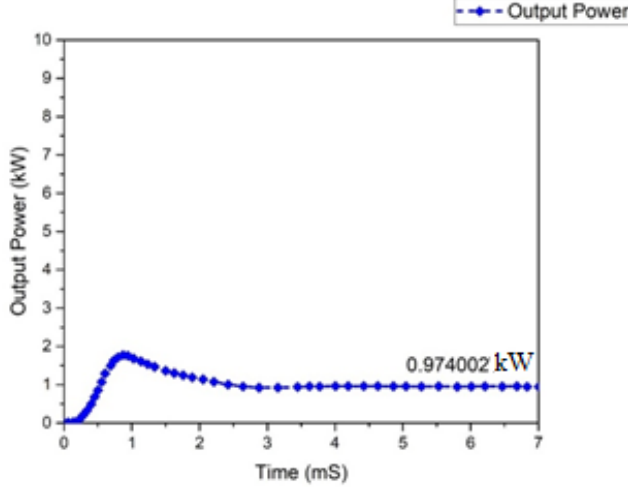
Figure 21. Output power of Flyback boost converter based (GaN ‐ HEMT).